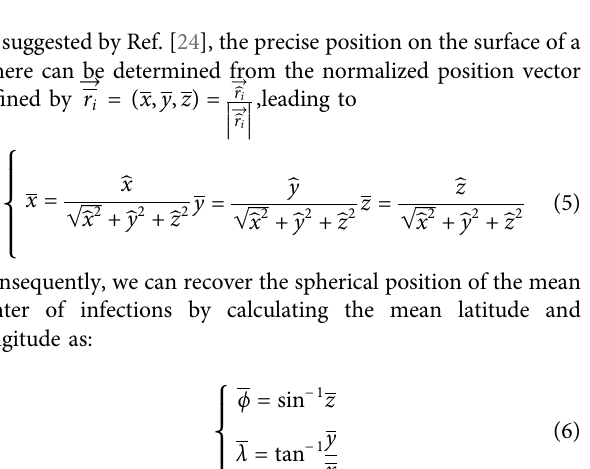
FIGURE3| Moran ’ sIindexanditscorresponding p -valueforcasesIIIandIVaccountingforpopulationandpopulationdensityofdifferentdistricts.Thedailyspread was not clustered with respect to district population and density until late August 2020, where it started achieving strong spatial clustering between districts of adjacent population